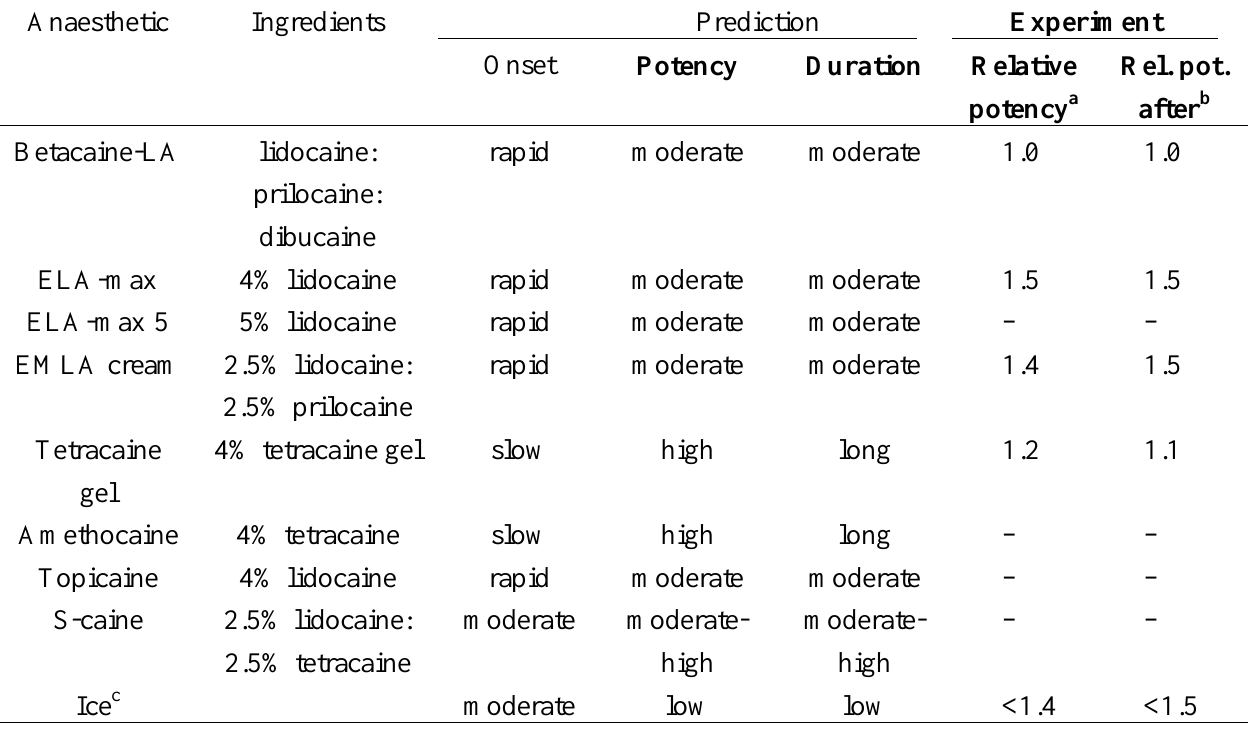
Table 3. Predictions for topical anaesthetics and ice both not included in the